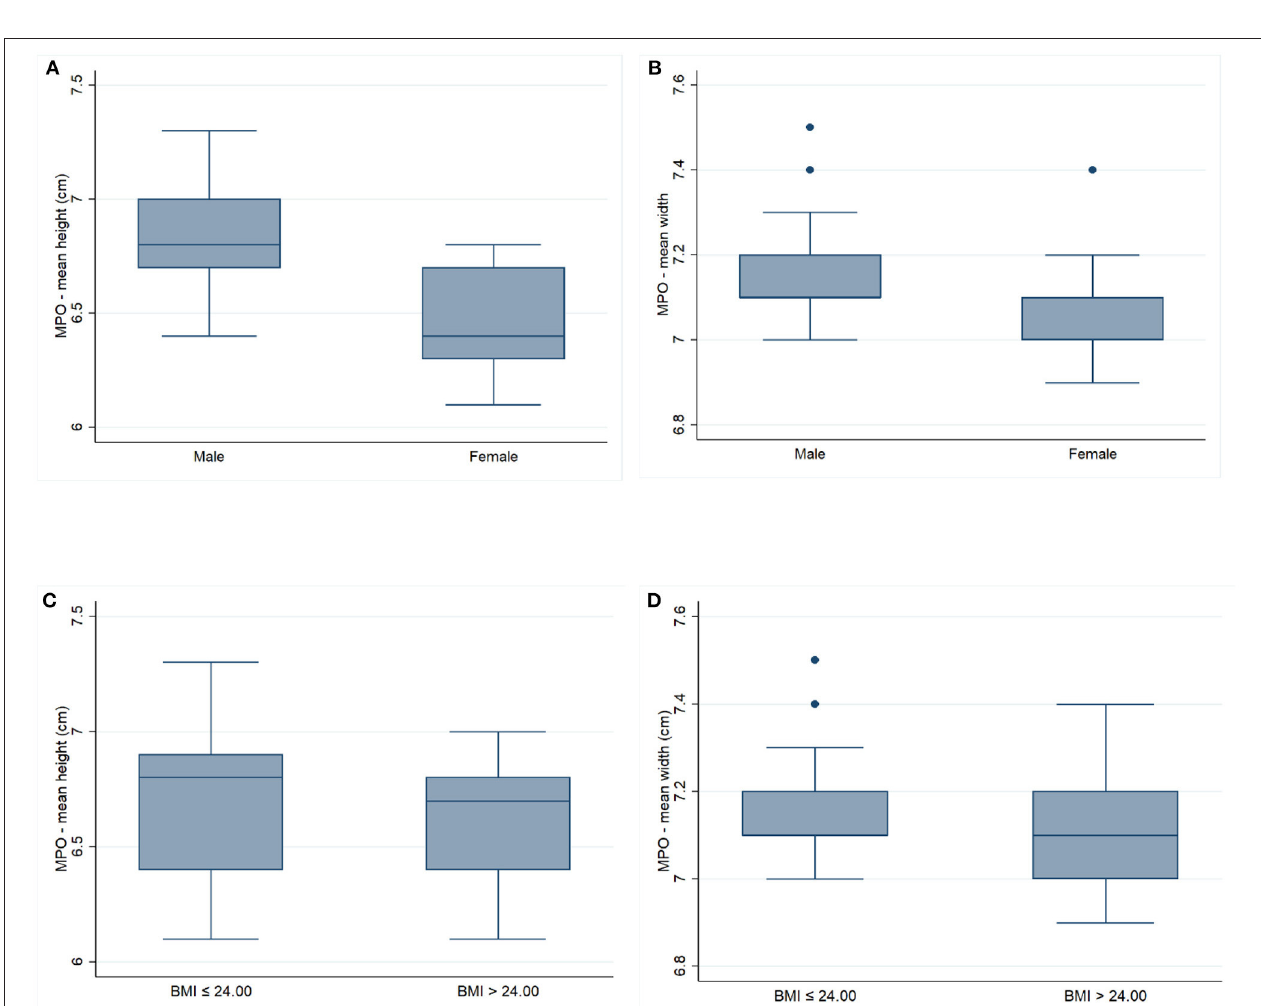
FIGURE 3 | The graph demonstrates the myopectineal orifice according to sex and body mass index; (A) mean MPO height in sex; (B) mean MPO width in sex; (C) mean MPO height in BMI; (D) mean MPO width in BMI.